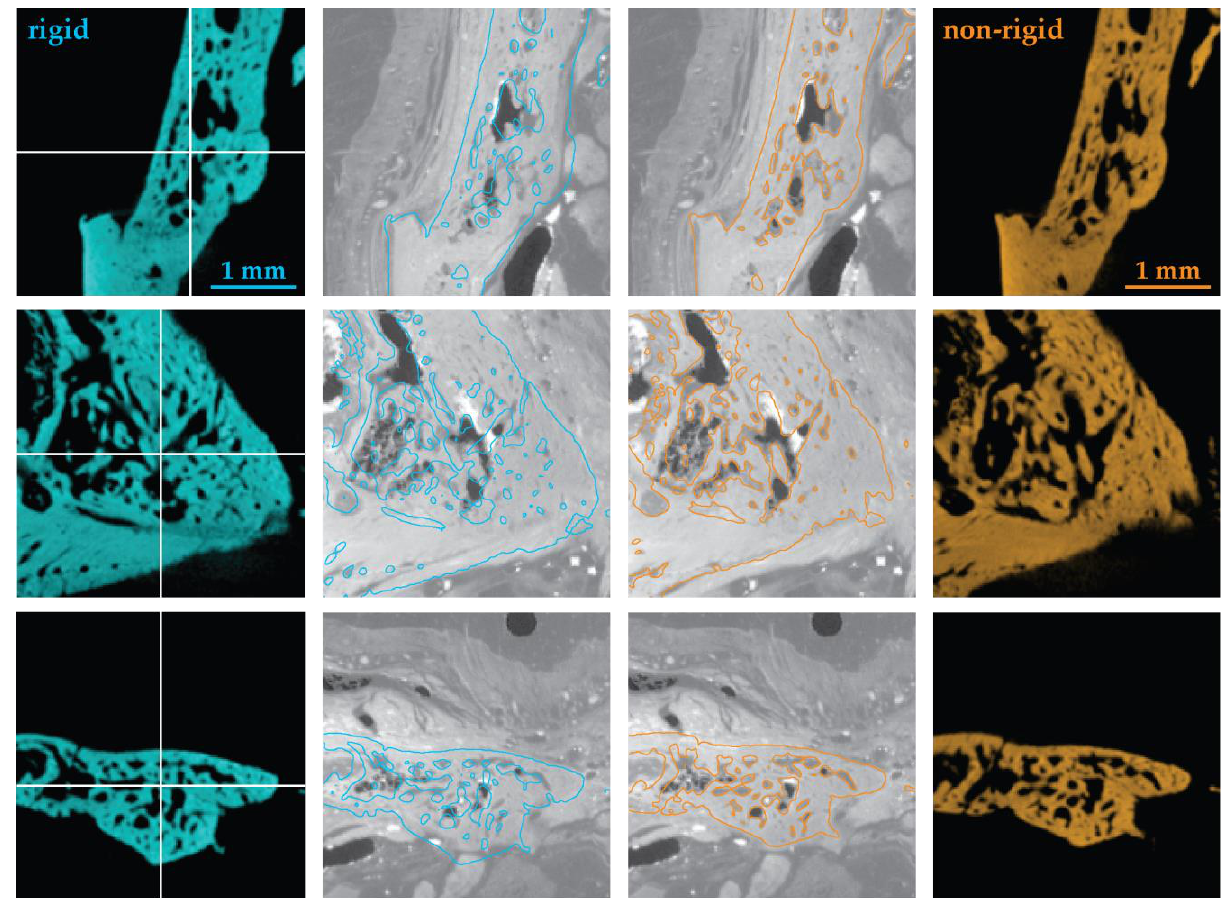
Figure 6. Turquoise- or orange-colored tomography data obtained before decalcification was registered, rigid and non-rigid, respectively, to the synchrotron radiation-based tomography data, grayscale image, and shown in the three orthogonal directions. Contour lines overlayed on the decalcified image show correspondence. The two middle columns demonstrate the need for the application of non-rigid registration procedures.